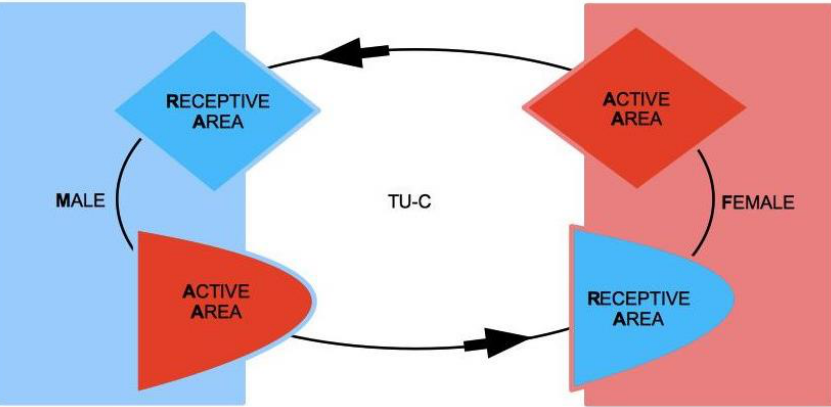
Figure 5. The sequence of activation of the four Areas.